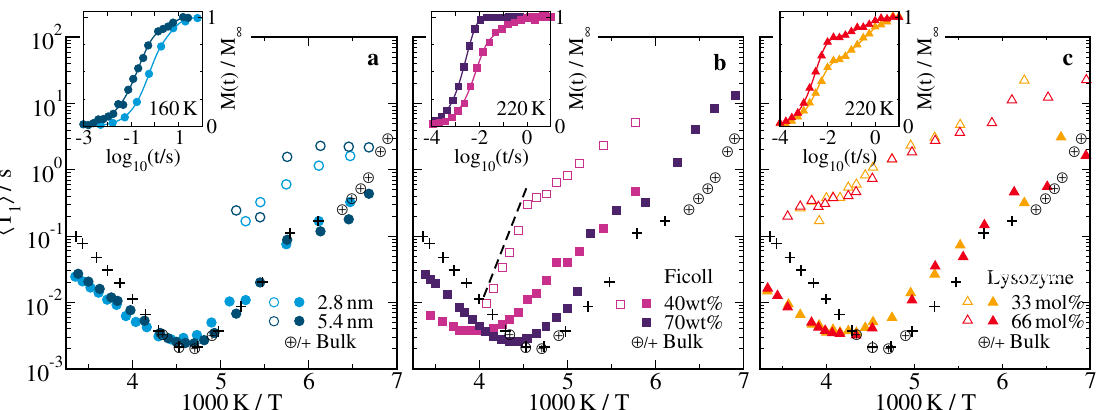
Figure 4. Temperature-dependent mean 2 H SLR times (cid:104) T 1, n (cid:105) of 66mol% D 2 O-DMSO- h 6 solution in ( a ) silica pores with diameters of d = 2.8nm and d = 5.4nm, ( b ) ficoll at solution mass fractions of w s = 70wt% and w s = 40wt%, and ( c ) lysozyme at a solvation level of s = 0.68 g sol / g lys . For the lysozyme matrix, results for a solution with 33mol% water are also included. In all panels, data for the 66mol% D 2 O-DMSO- h 6 bulk solution are shown for comparison, where present and previous [57] results are marked by crosses and circled crosses, respectively. The insets show exemplary normalized buildup curves M ( t ) / M ∞ . In panel ( b ), the dashed line indicates an Arrhenius law with an activation energy of E a = 65kJ/mol. All measurements were performed at the Larmor frequency ω 0 = 2 π · 46.1MHz.